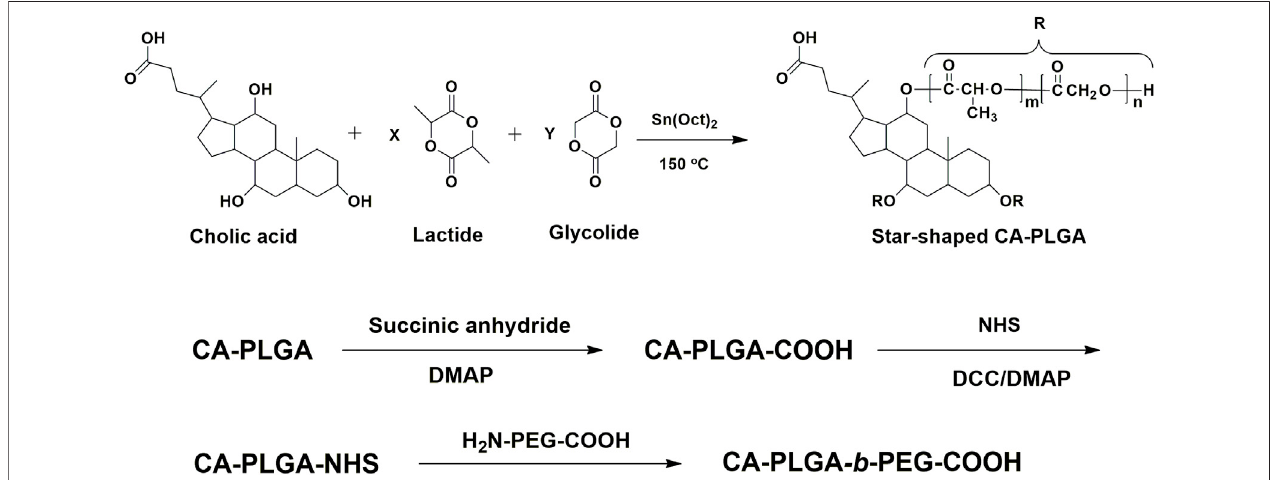
FIGURE 1 | Schematic representation of synthesis of amphiphilic block copolymer CA-PLGA- b -PEG-COOH.